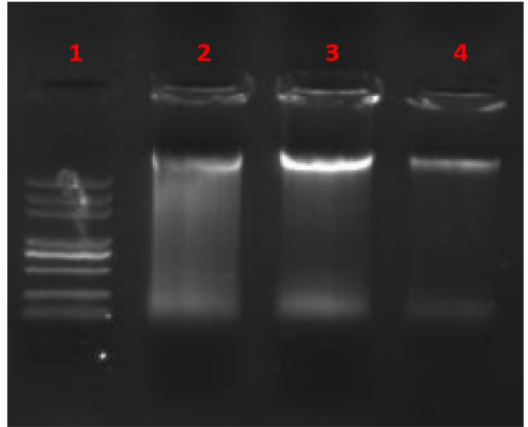
Figure 6. Gel retardation assay of BCp12. (1) Marker; (2–4) BCp12 at concentrations 1, 0, 2 mg/mL,